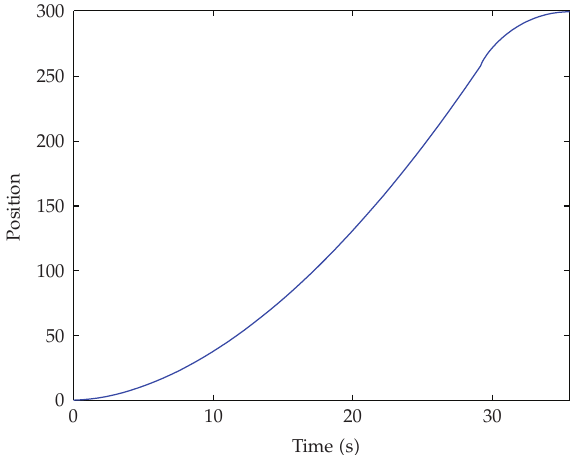
Figure 3: States x (cid:5) t (cid:6) as functions of time t for the Bang-Bang control problem for α (cid:7) 0 .